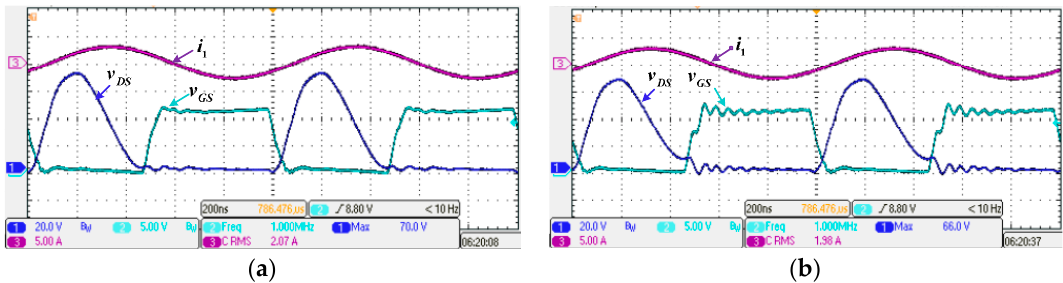
Figure 18. Waveforms of driver signal v GS , transmitter current i 1 , and drain-to-source voltage v DS , when iron plate at line l 3 . ( a ) d 3 = 15 cm; ( b ) d 3 = 5 cm.